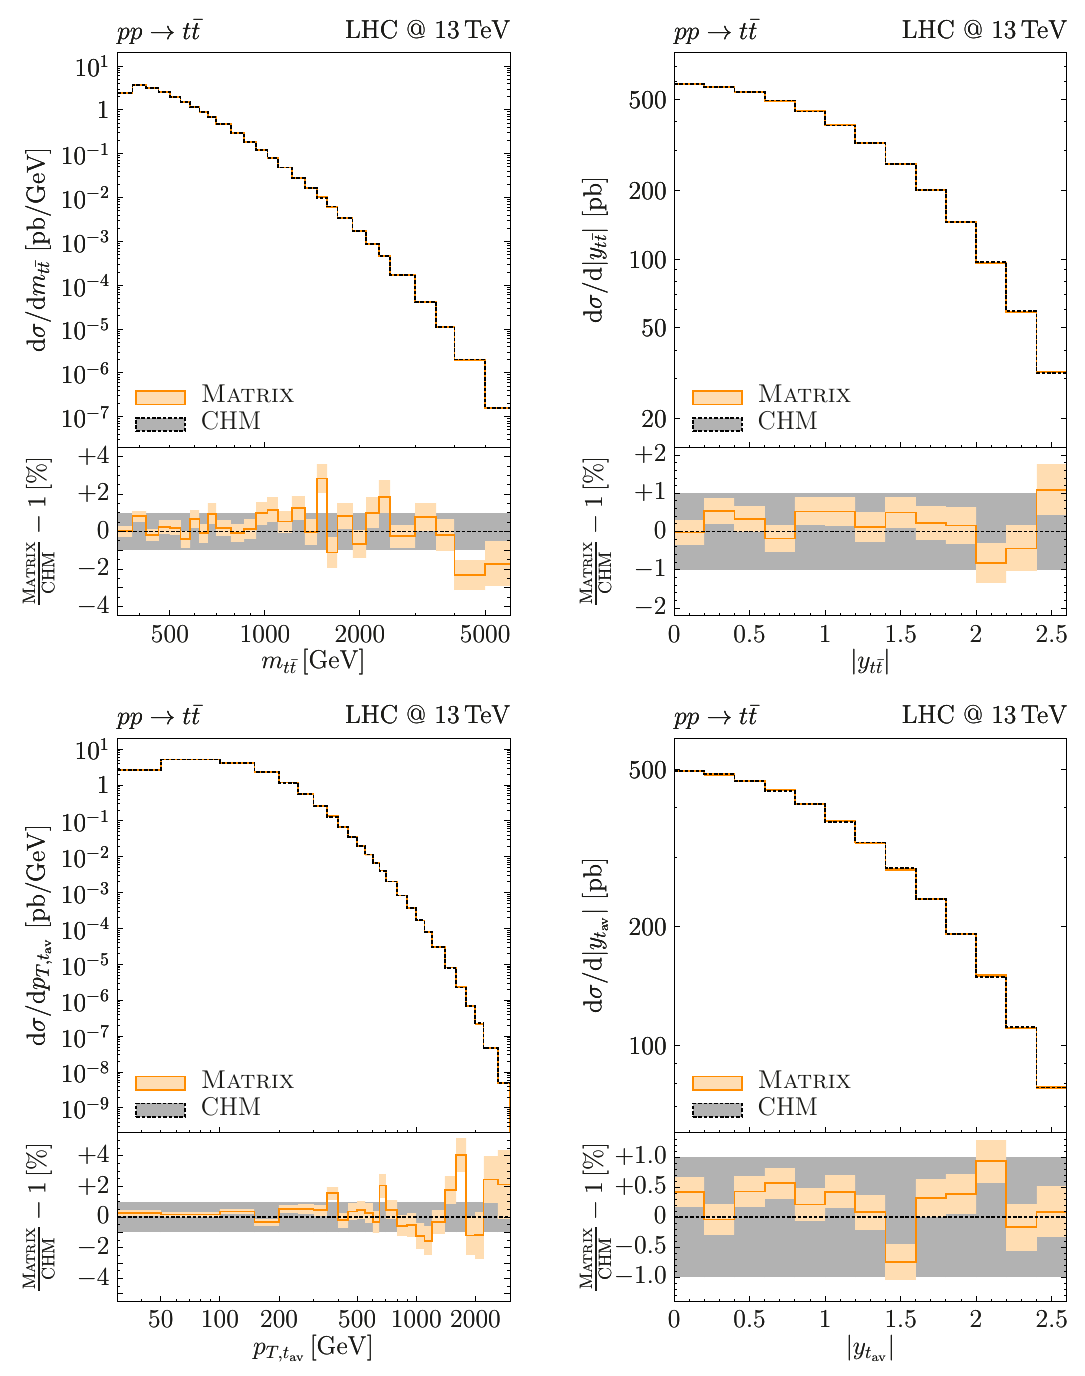
Figure 9 . Comparison between the NNLO di(cid:11)erential distributions obtained with Matrix (or- ange) and the results from ref. [97] (CHM, grey). The orange bands indicate the numerical uncer- tainty of our results, which is typically well below 1%. The grey band approximates the statistical uncertainty expected for the results of ref. [97], based on corresponding comments in the text therein.